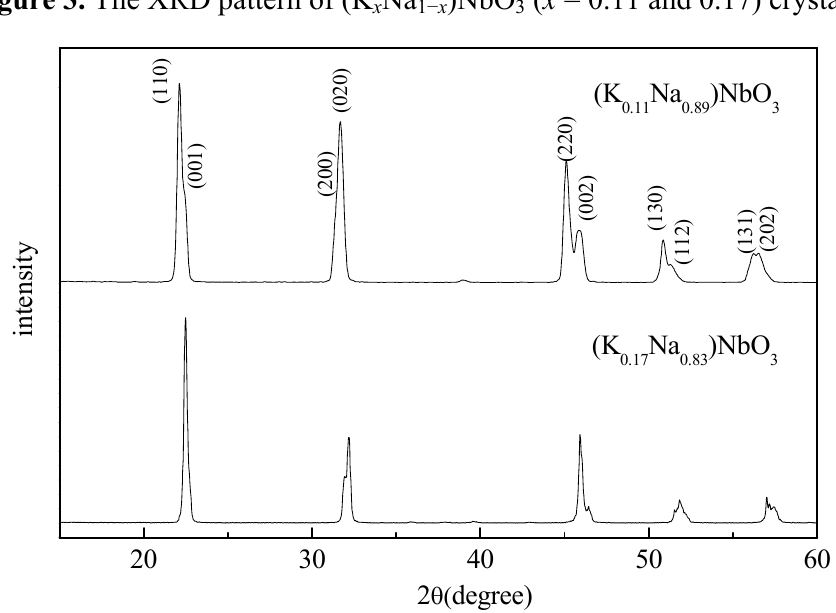
Figure 3. The XRD pattern of (K